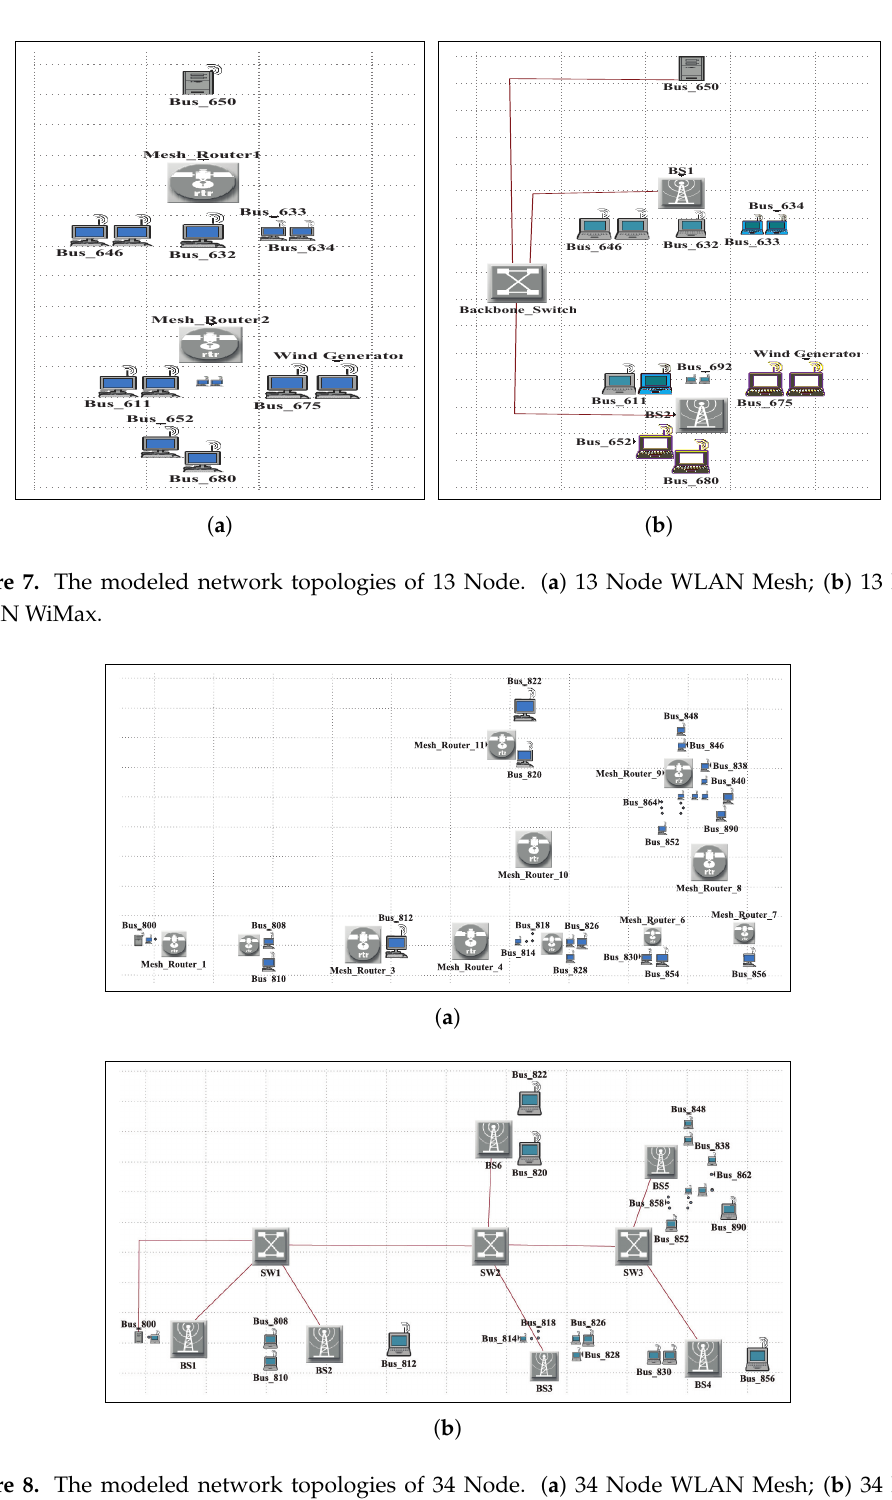
Figure 8. The modeled network topologies of 34 Node. ( a ) 34 Node WLAN Mesh; ( b ) 34 Node WLAN